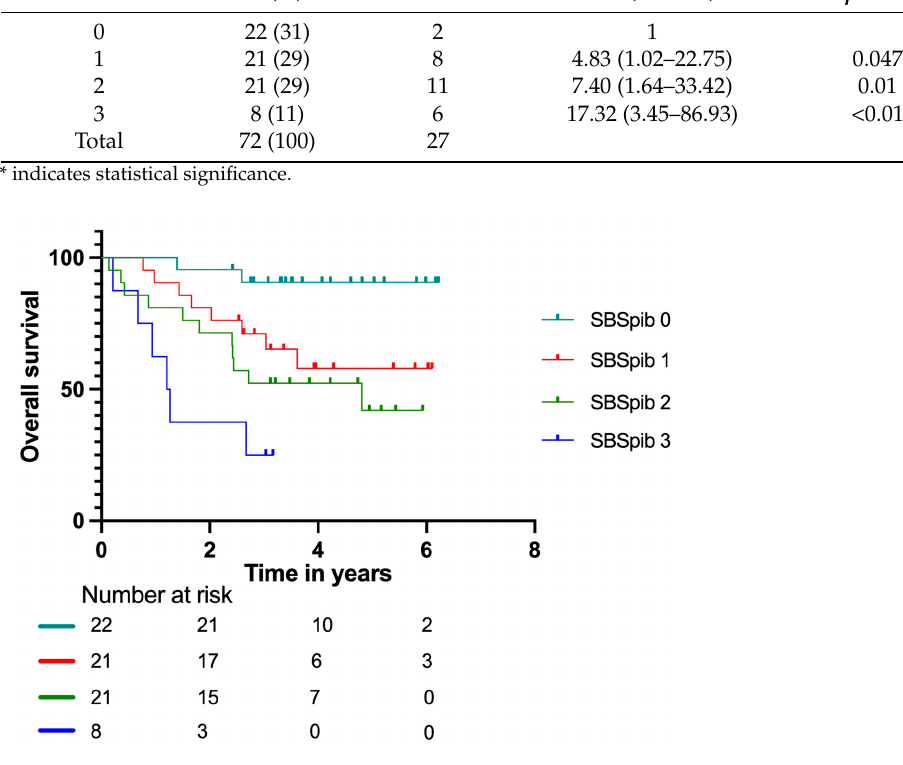
Figure 5. Kaplan–Meier survival curves with number at risk at baseline, two, four, and six years according to the Sarcoma Biomarker Score pet imaging and blood (SBSpib) model in patients with localized disease.